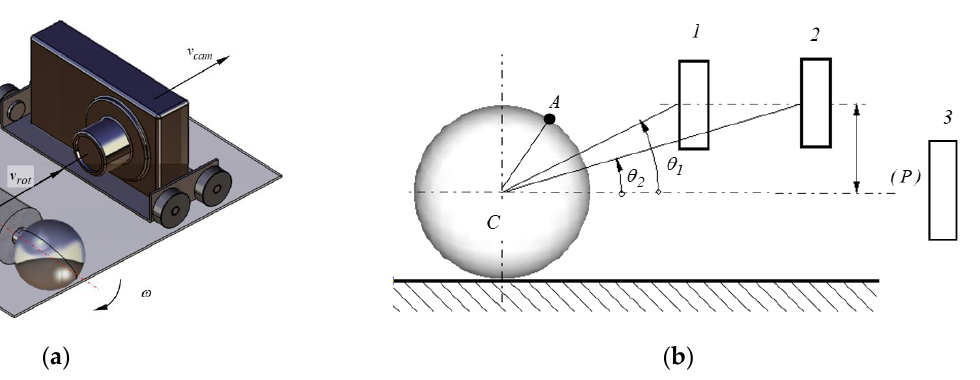
Figure 6. Principle of the moving camera: ( a ) schematics of moving rotor and mobile camera; ( b ) method for avoiding the parallax error.